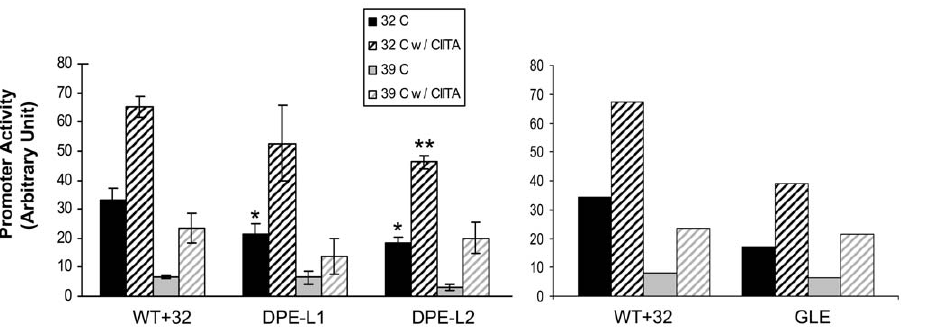
Figure 7. GLE, DPE-L1, and DPE-L2 function differently in TAF1-dependent transcription and TAF1-independent CIITA-mediated transcription. The transcriptional activity regulated by DPE-L1 and DPE-L2 (Left panel) and GLE (Right panel) depend on a functional TAF1. tsBN462 cells were co-transfected at the permissive temperature (32 u C)with a CIITA-expression or control vector (which are not TAF1-dependent) and either wild type (WT + 32), DPE-L1, DPE-L2 or GLE constructs. All constructs shared common 5 9 and 3 9 termini at 2 416 and + 32, respectively. After 24 hours, cells were either shifted to the non-permissive temperature (39 u C) or left at 32 u C for an additional 24 hours prior to harvesting. Promoter activity was assessed by CAT activity as described in Materials and Methods. The results are the representative of two separate sets of independent experiments, each done with independent duplicate transfections. (*) and (**) denote significant differences between the activities of mutant constructs relative to the wild type at 32 u C or 39 u C with CIITA, respectively.